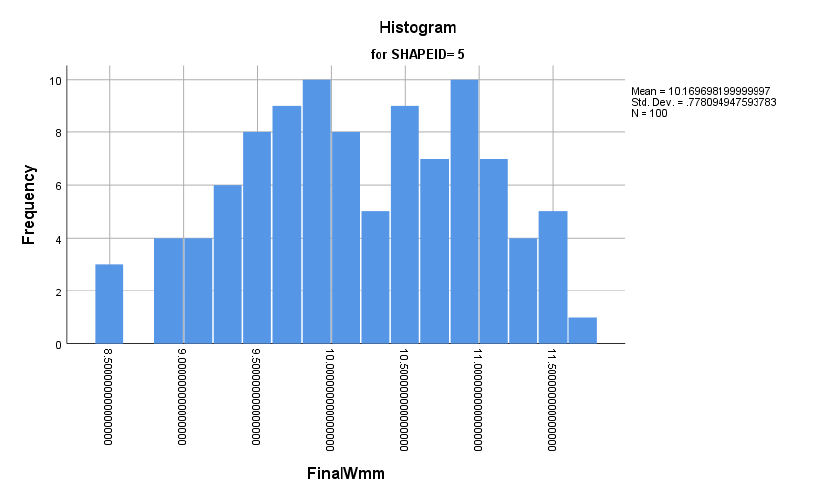
Figure A11. Shrink width adjustment for 10